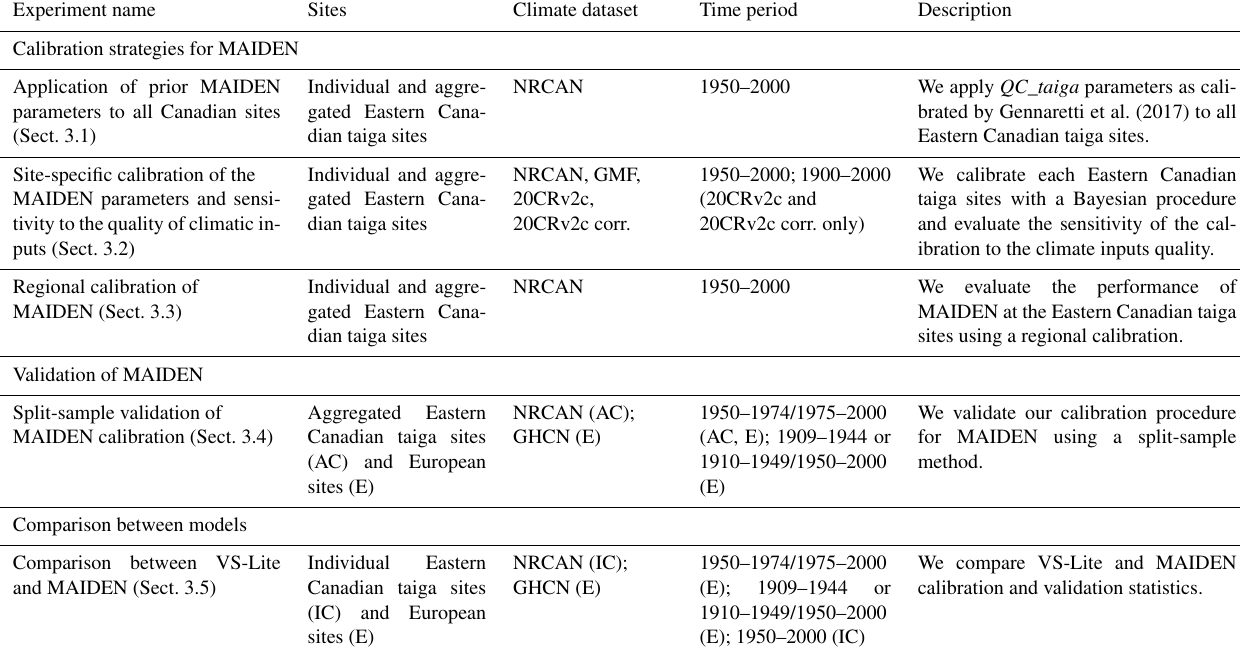
Table 3. Description of each experiment performed in our study: experiment name, sites and climate dataset used for the experiment, time period of the experiment, and short description of the experiment. Information on climate datasets can be found in Table 2. Individual and aggregated Eastern Canadian taiga sites refer to Fig. 1 and European sites refer to Fig.